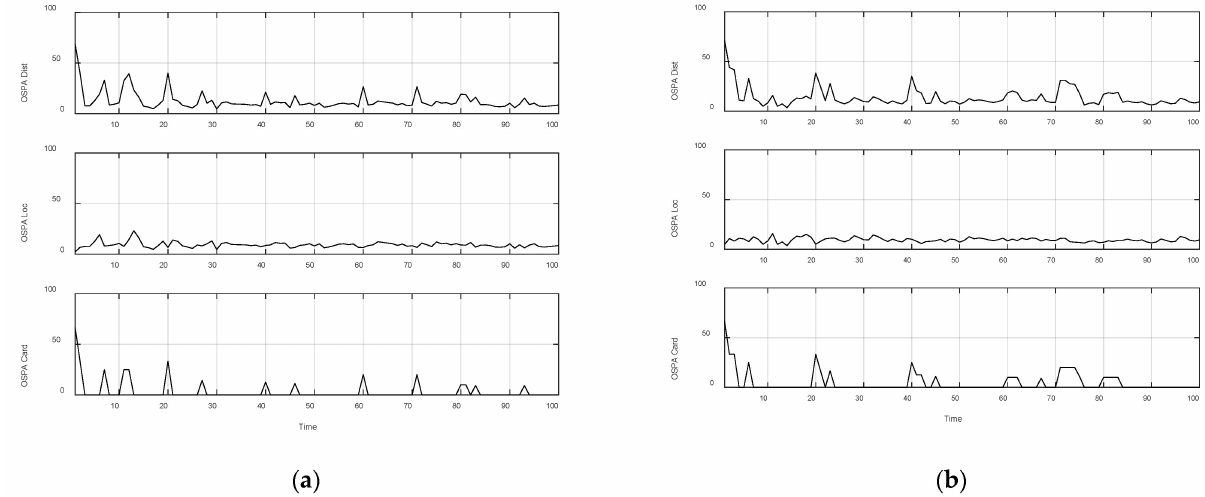
Figure 15. OSPA distance. (100 Mont Carlos: ( a ) OSPA distance of LMB filter algorithm; ( b ) OSPA distance of GLMB filter